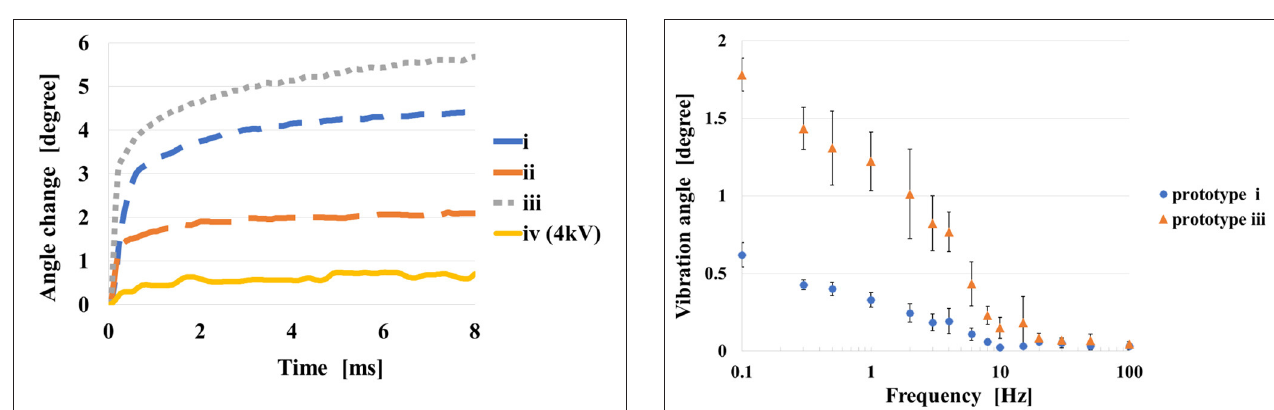
FIGURE 12 | Comparison of four prototypes at the applying voltage of 5 kV.